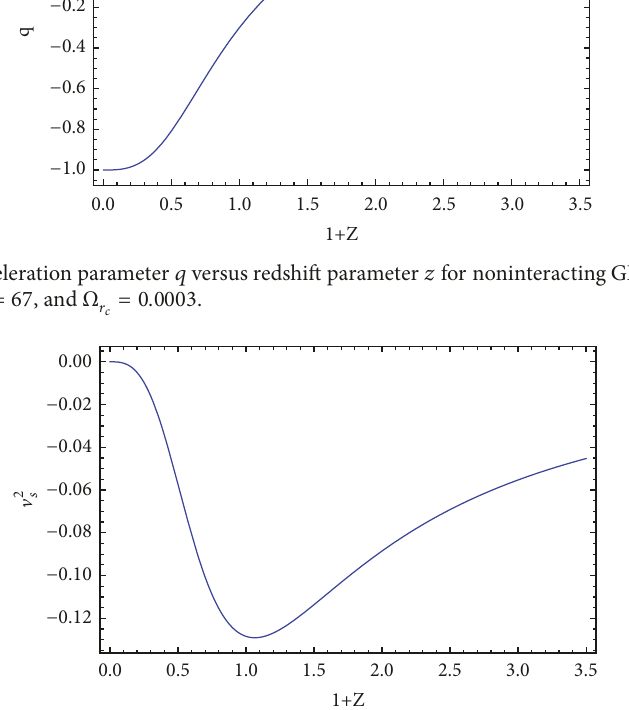
Figure 4: The evolution of the squared of sound speed V 2 𝑠 versus redshift parameter 𝑧 for noninteracting GDE in DGP model. Here, we have taken Ω 𝐷 (𝑧 = 0) = 0.73 , 𝐻(𝑧 = 0) = 67 , and Ω 𝑟